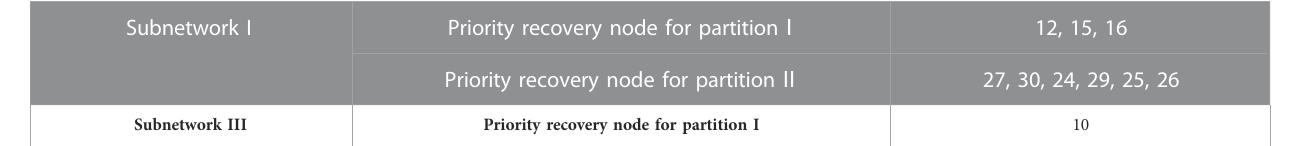
TABLE 10 First and third priority recovery load nodes of